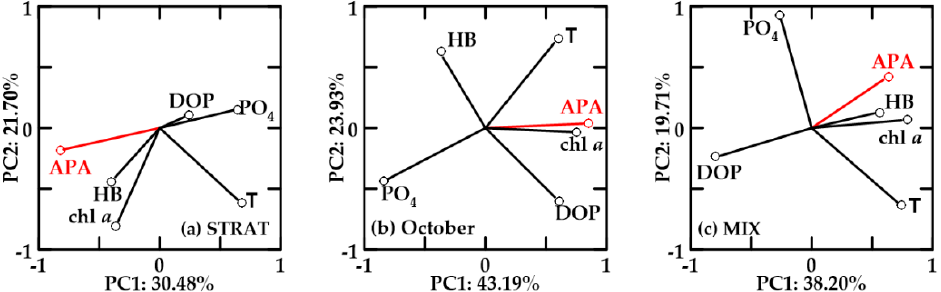
Figure 11. Principal component analysis (PCA) for relevant variables in oxygen ‐ undersaturated waters in ( a ) STRAT, ( b ) October, and ( c ) MIX. Abbreviations are reported in Figure 8.